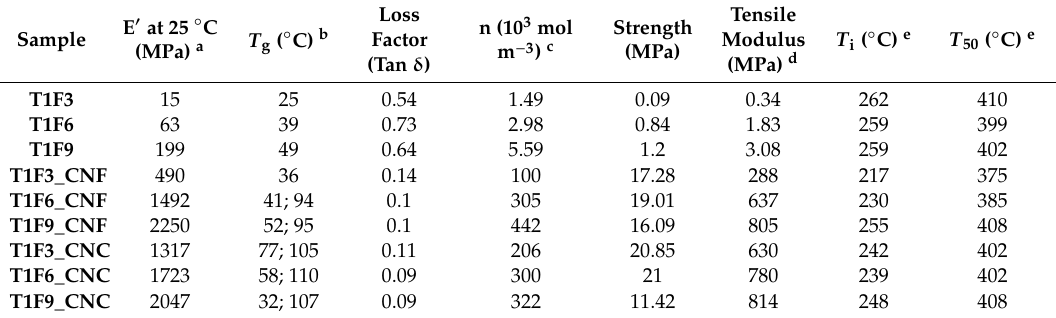
a E ′ : storage modulus, b T g : glass transition temperature from dynamic mechanical analysis (DMA), c n: crosslinking density, d Tensile modulus were calculated from stress-strain plot. e T i : initial degradation temperature from TGA, e T 50 : 50% weight loss temperature from TGA.